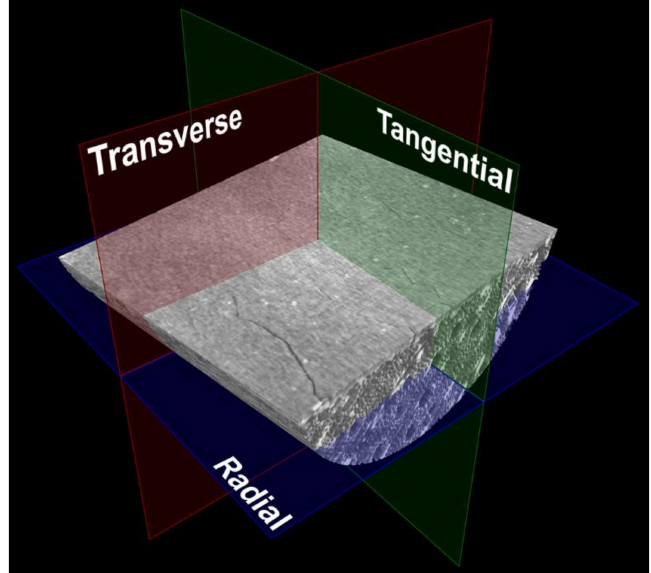
Figure 2. Planes considered for the virtual slicing of SR-micro-CT volume renderings (fragment F01 is shown here as an example). These planes produce 2D images of radial, tangential, and transverse sections of the